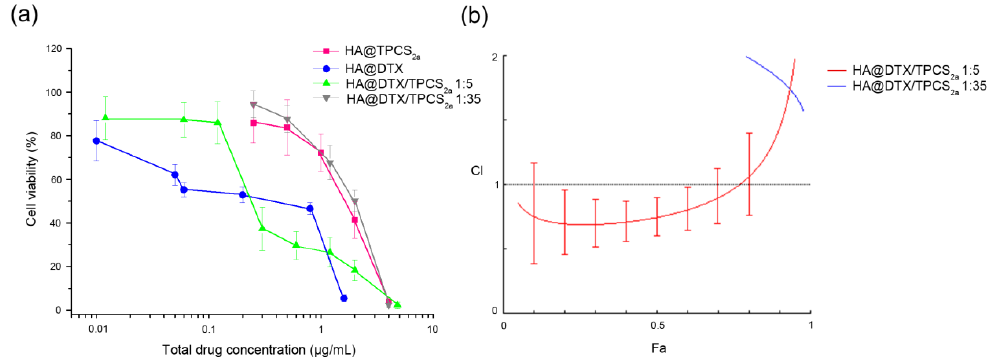
Figure 2. Cytotoxicity of single and combined treatments in differentiated MCF-7 cells cultured as monolayers. ( a ) Dose-response curves of cells incubated for 24 h with single drugs or their combination loaded in HA-NPs and irradiated with 1 J/cm 2 of red light (600 – 800 nm) when PDT was part of the treatment. After additional 24 h in drug-free medium, cell viability was measured with the MTS assay. Total drug concentration is referred to DTX + TPCS 2a concentration. Data are expressed as mean percentage ± SD of at least three independent experiments, carried out in triplicate. ( b ) Plots of combination index (CI) vs. fraction a ff ected (Fa) relative to cells treated with HA@DTX / TPCS 2a -NPs loaded with DTX and TPCS 2a in the 1:35 (blue) or 1:5 (red) molar